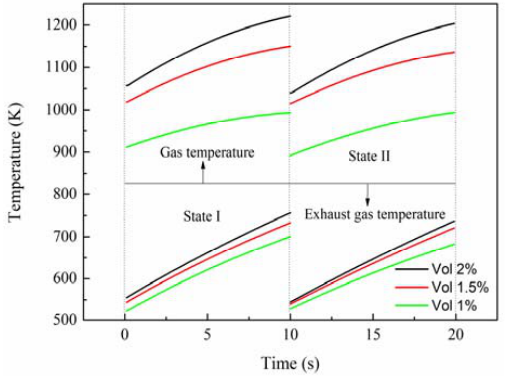
Figure 5. The effect of methane concentrations on the gas temperature; v = 20 m/s.